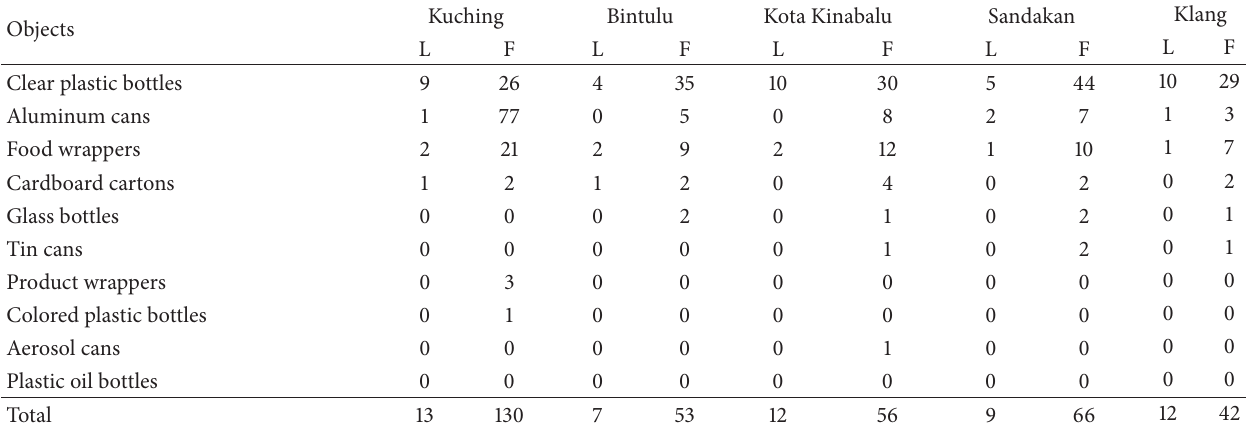
Table 7: Total objects (item/vessel) origins found at ship survey.